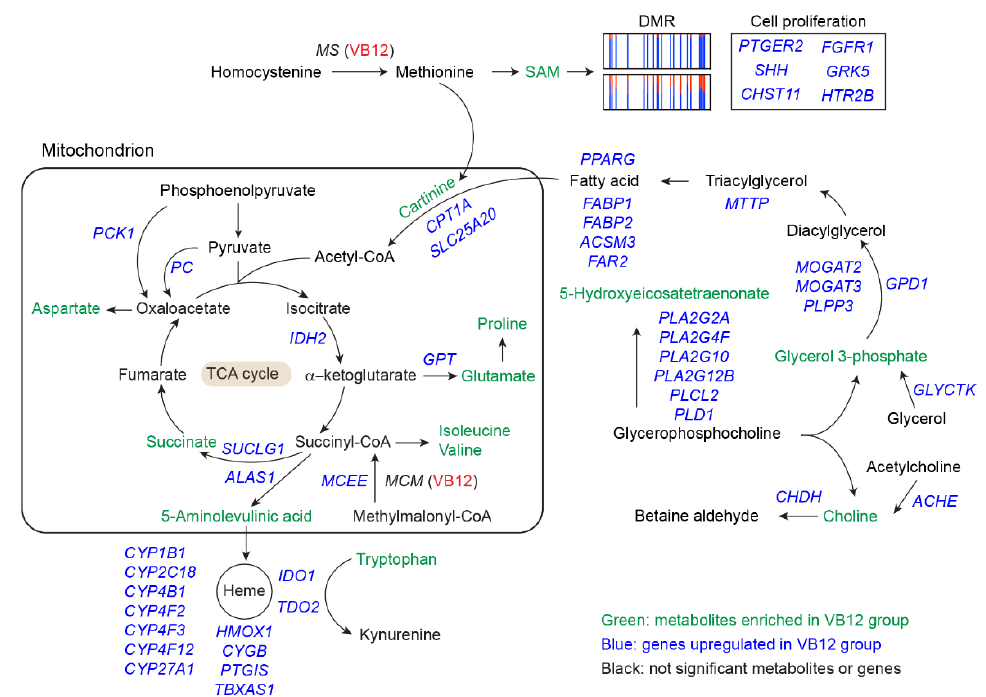
Figure 5. Summary model based on transcriptomic, metabolomic, and epigenomic integration. As a crucial co-factor for MCM, VB12 supports the generation of succinyl-CoA, which can participate in the TCA cycle and serve as the precursor for heme biosynthesis, resulting in the activation of heme enzymes. VB12 also facilitates fatty acid metabolism, which potentially generates free fatty acids that can be transported into mitochondria to fuel the TCA cycle through the carnitine shuttle. Further, VB12 sustains the MS activity to enhance the biosynthesis of carnitine and SAM, which supports the carnitine shuttle and influences epigenetic programs of genes involved in cell proliferation. An elevated TCA cycle also contributes to the production of amino acids that are essential for cell